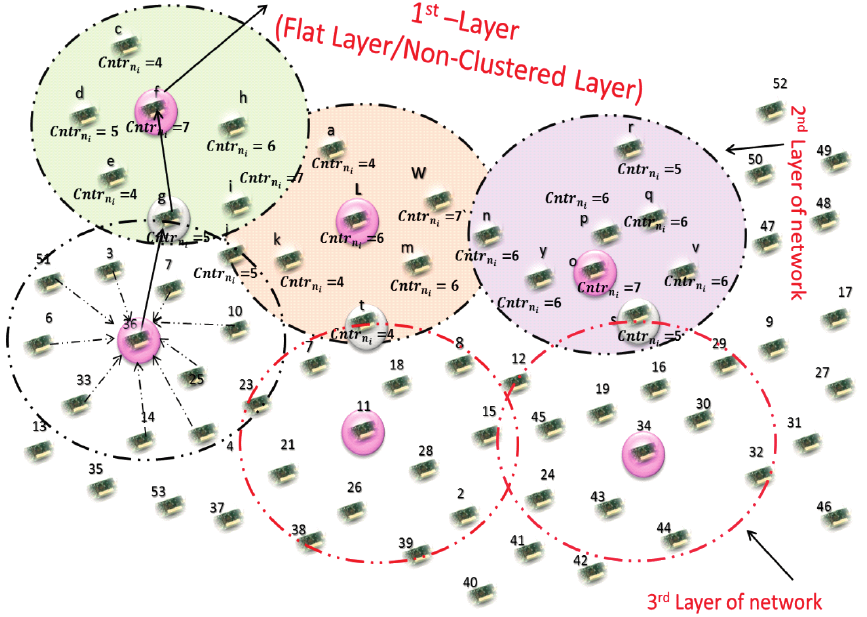
Figure 4. Intra-cluster and inter-cluster routing in MCDA